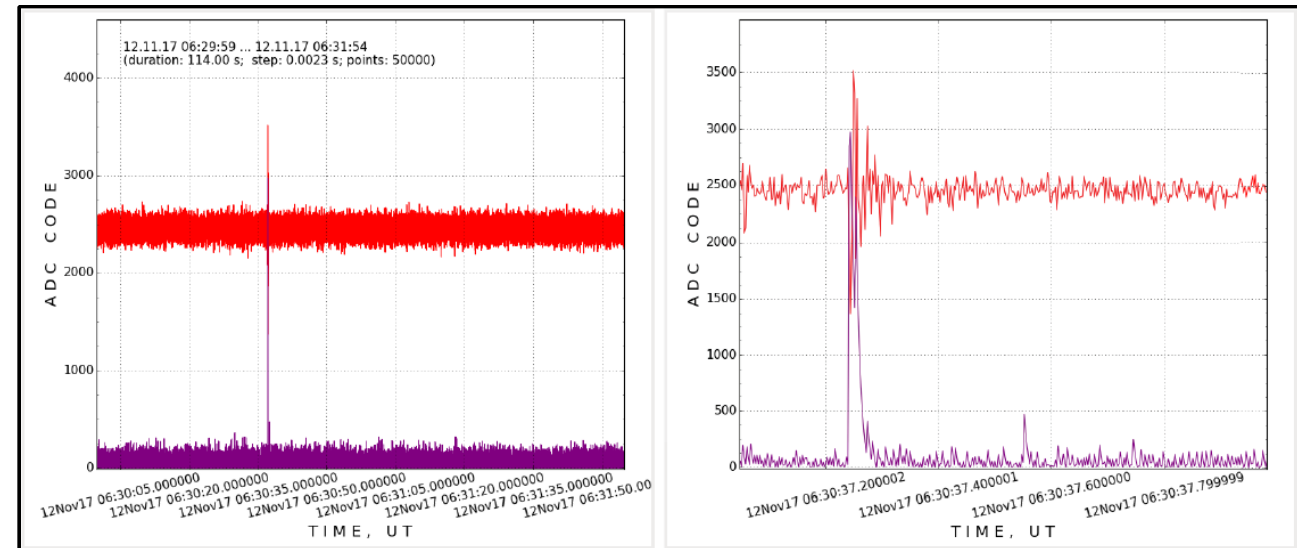
Figure 5. Visualization of the recording of signals from an acoustic detector in the graphic window of the application program. The top graph in the left figure is the microphone signal, the lower graph is the low-frequency envelope. In the right figure, the time domain around the short-term burst of intensity observed in the acoustic signal is stretched along the horizontal axis.